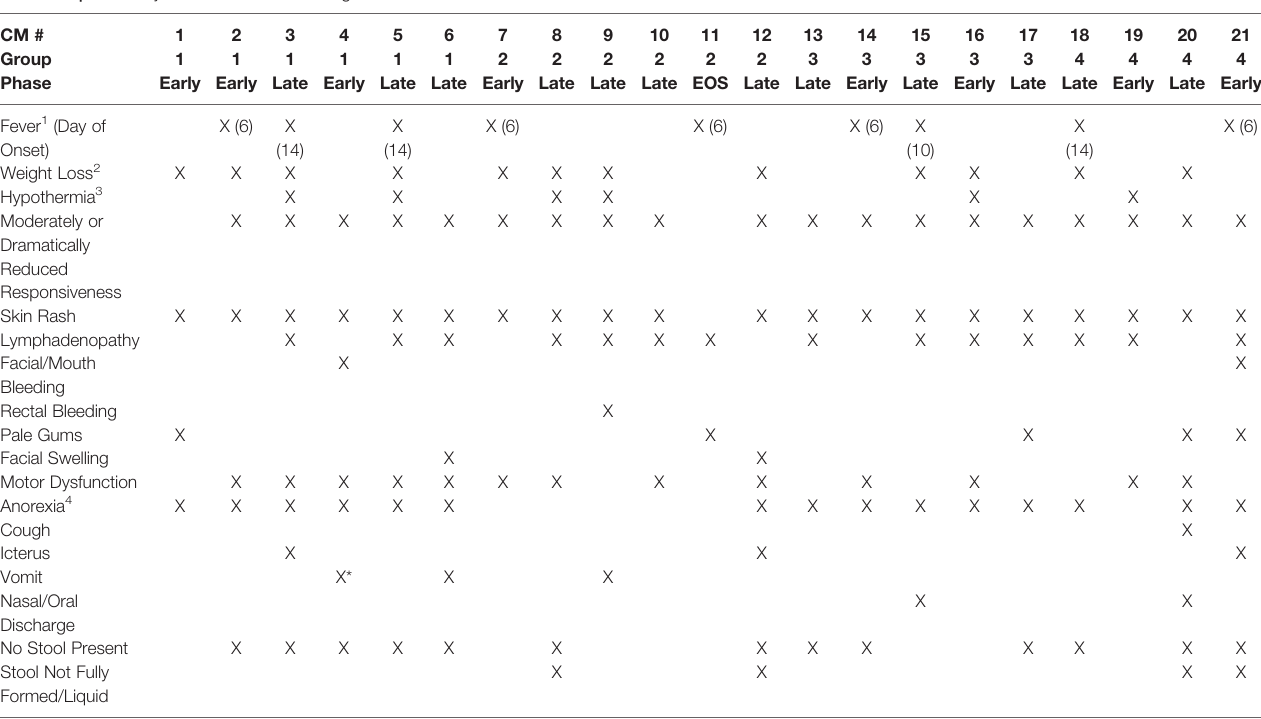
TABLE 2 | Summary of clinical disease fi